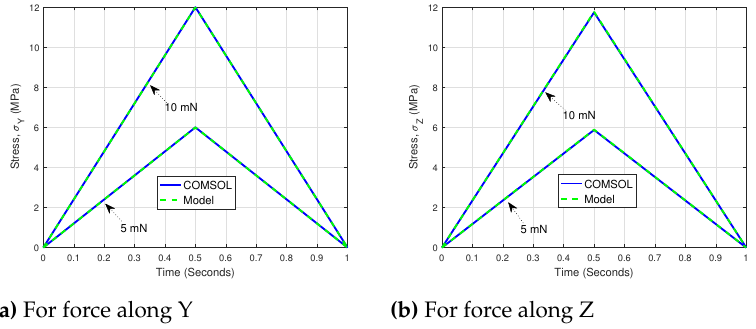
Figure 5. Comparison of analytical model and COMSOL